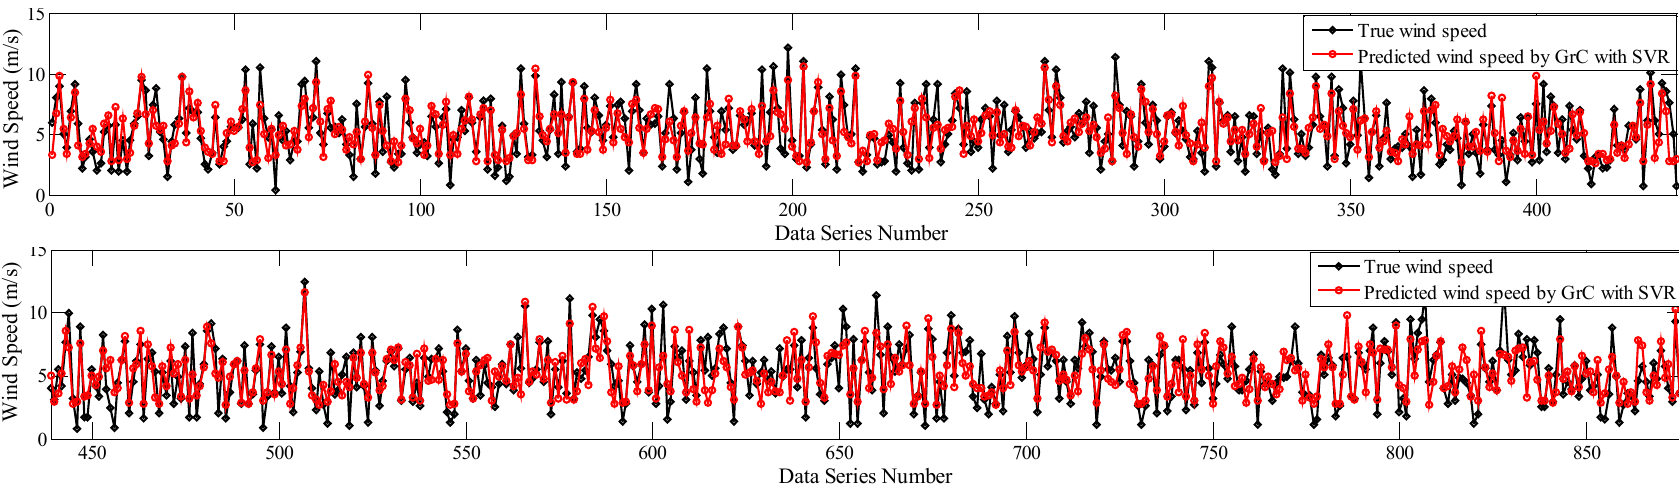
Figure 16. Comparisons between true wind speed and wind speed predicted by the granular computing method. The comparisons are proceeded in one class of ten-fold cross validation processes. Table 6. Evaluation metrics comparisons between granular method and traditional methods.